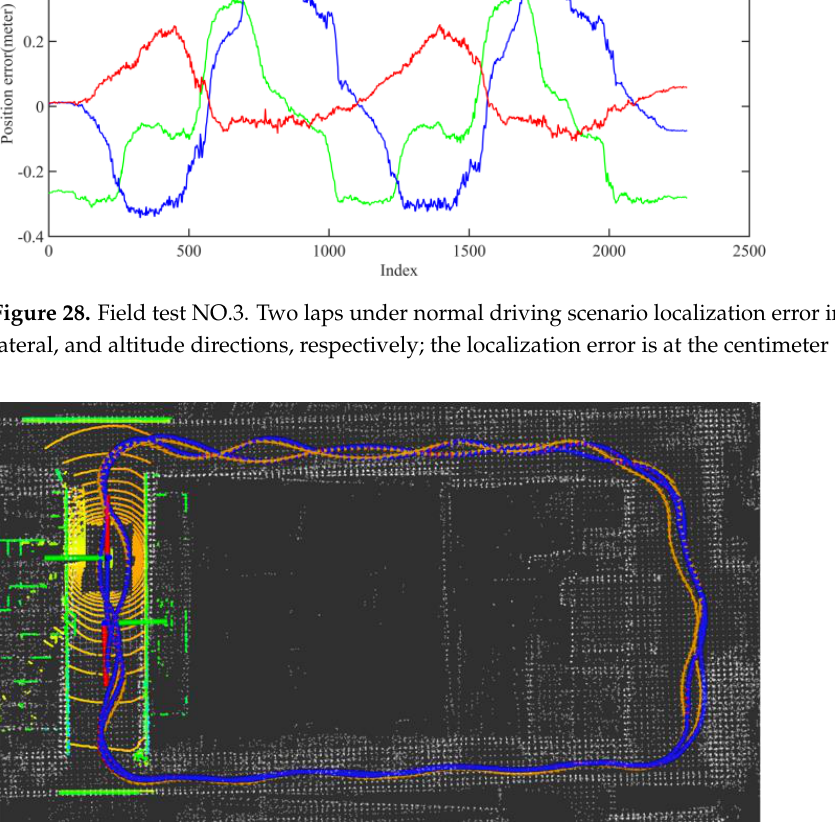
Figure 29. Field test NO.4. Two laps under curve driving scenario localization test in prior point cloud map. The white points in the figure are the point cloud map built by the offline mapping process, the red line is the trajectory of LiDAR matching results, the orange line is groundtruth, and the blue line is the fused trajectory.